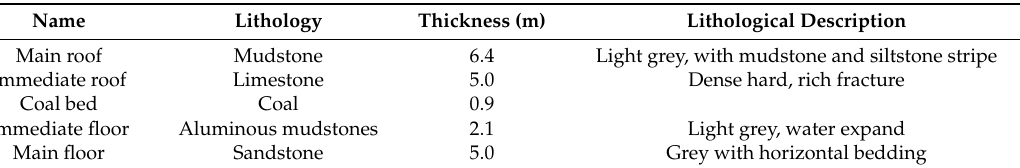
Figure 6. Location of the test site. Table 1. Roof and floor lithology of panel